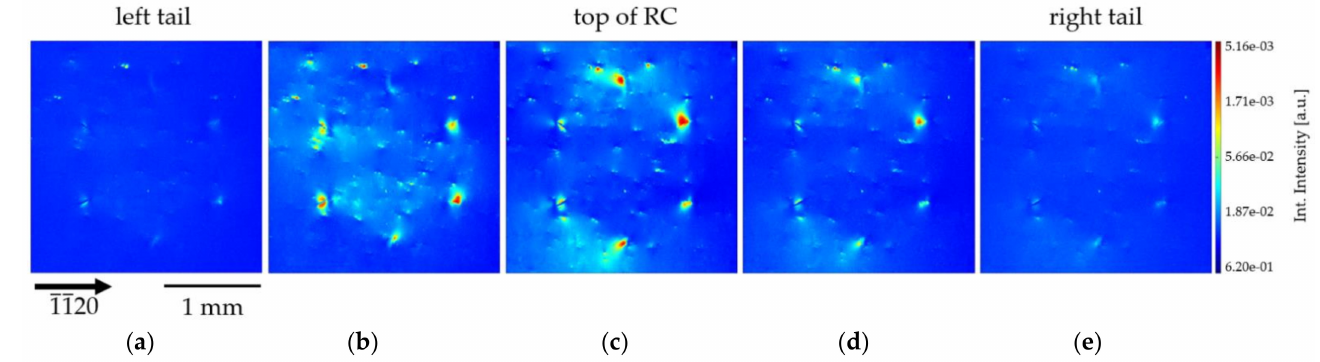
Figure 10. A series of individual images recorded on the HCD-A (from Figure 2b) for several angular positions along the rocking curve: going from its left tail, through the top, and to its right tail. The detailed description of the individual images ( a – e ) is given in the text. ( c ) image taken in the center of the rocking curve ( Θ centre ), ( b , d ) images from the steeply rising and steeply falling flanks of the rocking curve, ( a ) image from the left tail and ( e ) image from the right tail far away ( ∆Θ ~ ± 60 µ radian) from the maximum Θ centre of the rocking curve,